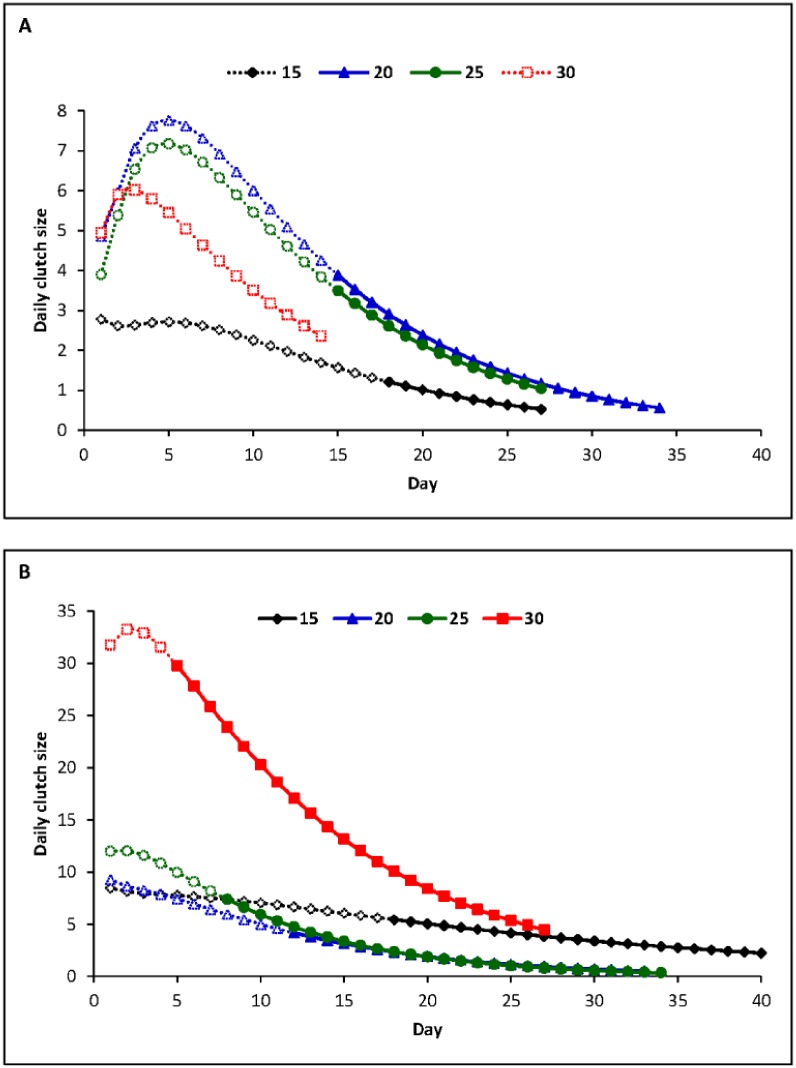
Daily clutch sizes at different temperatures.A, B. kugenumaensis. B, E. braueriana.